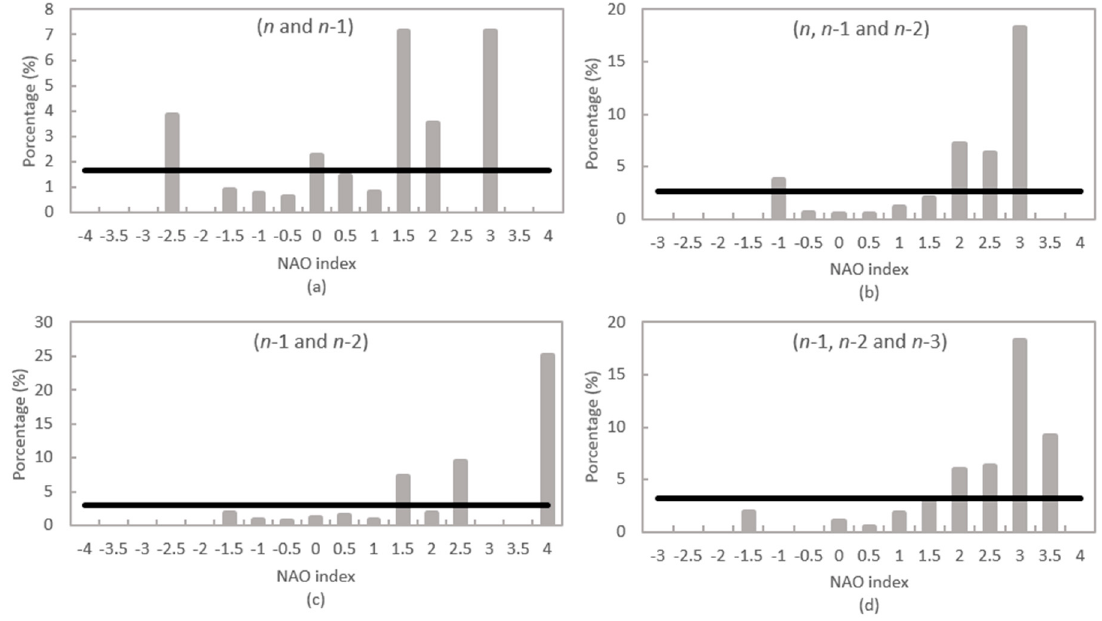
Figure 6. Percentage of pro-pluvia rogations associated to the average value of NAO for: ( a ) n and n -1; ( b ) n , n -1 and n -2; ( c ) n -1 and n -2; ( d ) n -1, n -2 and n -3. Black line is the distribution of the null hypothesis for each case.